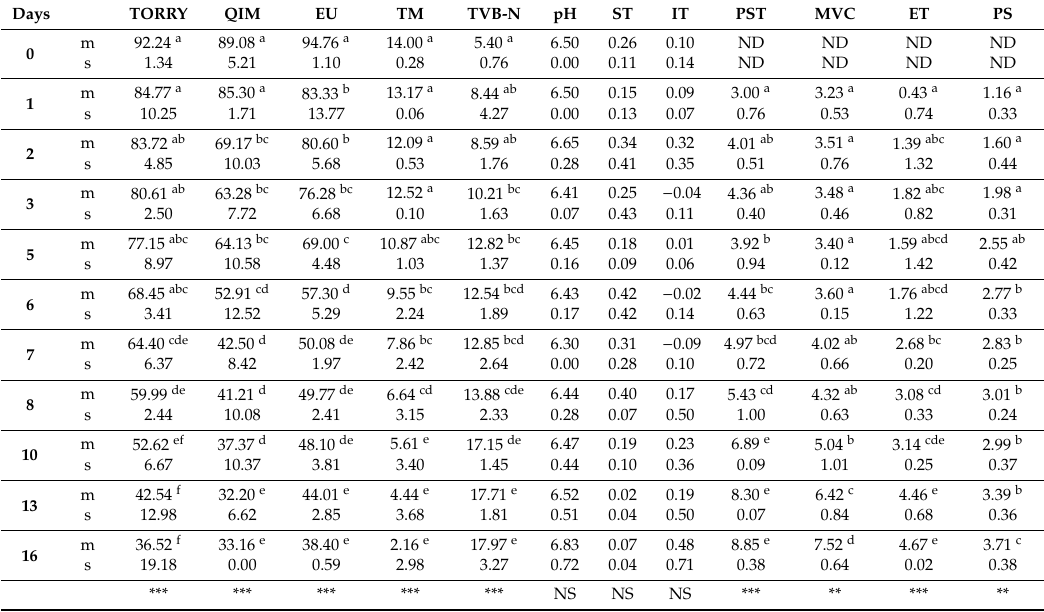
Table 1. Quality parameters for iced sea bream over storage time.